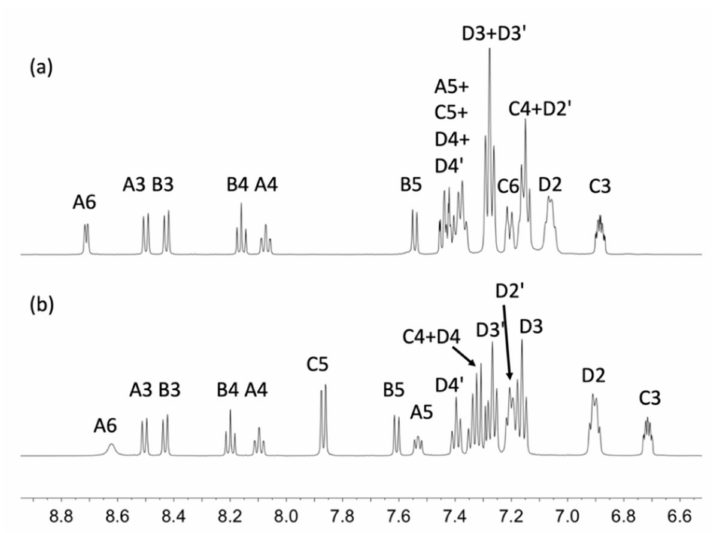
Figure 4. Aromatic regions of the 1 H-NMR spectra (500 MHz, acetone-d 6 , 298 K) of ( a ) [Cu(POP)( 1 )][PF 6 ] and ( b ) [Cu(xantphos)( 1 )][PF 6